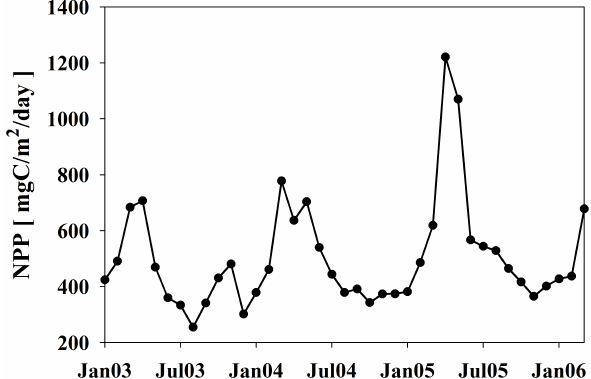
Fig. 5. Monthly averaged net primary production values recorded in the study area during the sampling